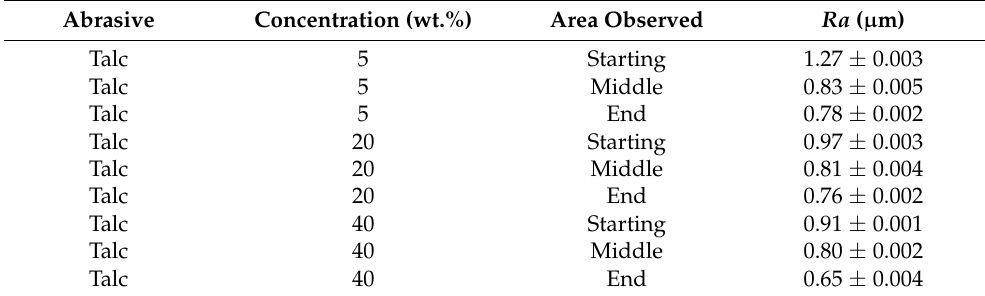
Table 5. Roughness of AISI 4145H steel after being abraded by slurry with talc. Abrasive Concentration (wt.%) Area Observed Ra ( µ m) Talc 5 Starting 1.27 ± 0.003 Talc 5 Middle 0.83 ± 0.005